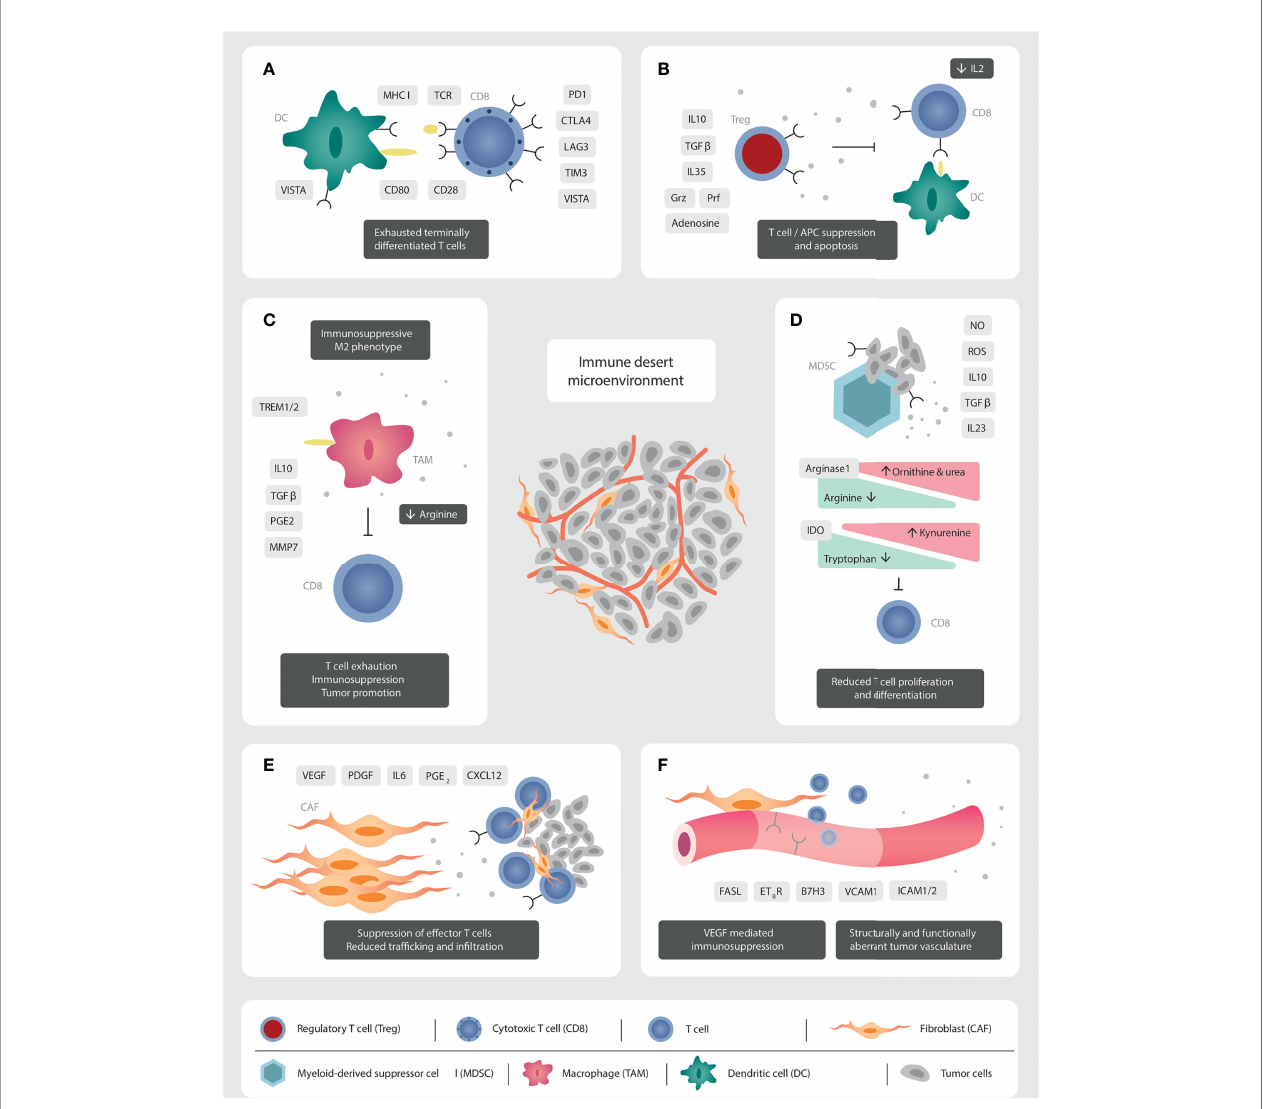
FIGURE 1 | Mechanisms of immunosuppression in the prostate cancer TME. (A) The TILs present are functionally exhausted, expressing a terminally differentiated phenotype. High PD1/PD-L1 signalling leads to a clonally restricted TCR repertoire. (B) The abundant Tregs produce immunosuppressive cytokines (IL10, TGF b , IL35), reduce IL2 concentrations through binding with CD25, and have direct cytolytic effects over T cells through granzyme and perforin secretion. (C) The immunosuppressive secretome of TAMs inhibit immune effector cells function and migration. Androgen receptor signalling via TREM plays a crucial role in production of immunosuppressive cytokines. (D) MDSC modulate metabolic pathways through the production of nitrate oxide and reactive oxygen species, which induce T cell anergy and apoptosis. CD8 T cell function is inhibited through the production of IL10, TGF b , and the reduction in arginine and tryptophan concentrations. IL23 promotes androgen resistance and tumorigenesis. (E) CAFs reduce cell traf fi cking and migration through the production of a stromal extra-cellular matrix barrier. Tumor promoting CAFs inhibit immune effector cell function through the production of an immunosuppressive secretome. (F) Structurally and functionally aberrant tumor neo-vasculature impedes effector cells traf fi cking and migration. VEGF induces downregulation of vascular adhesion molecules to impede cellular anchorage and